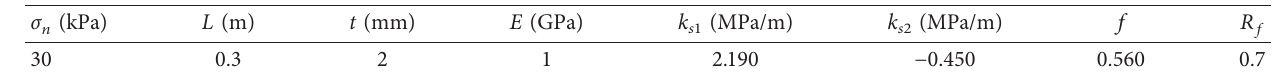
Table 7: Softening model parameters.